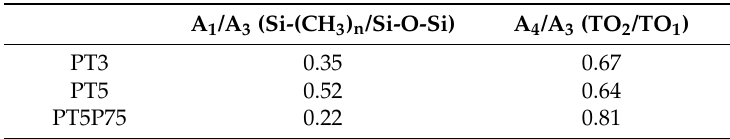
Table 4. Ratios between surface areas under some of the components in the Fourier transform infrared spectroscopy (FTIR) curve-fitting model (Figure